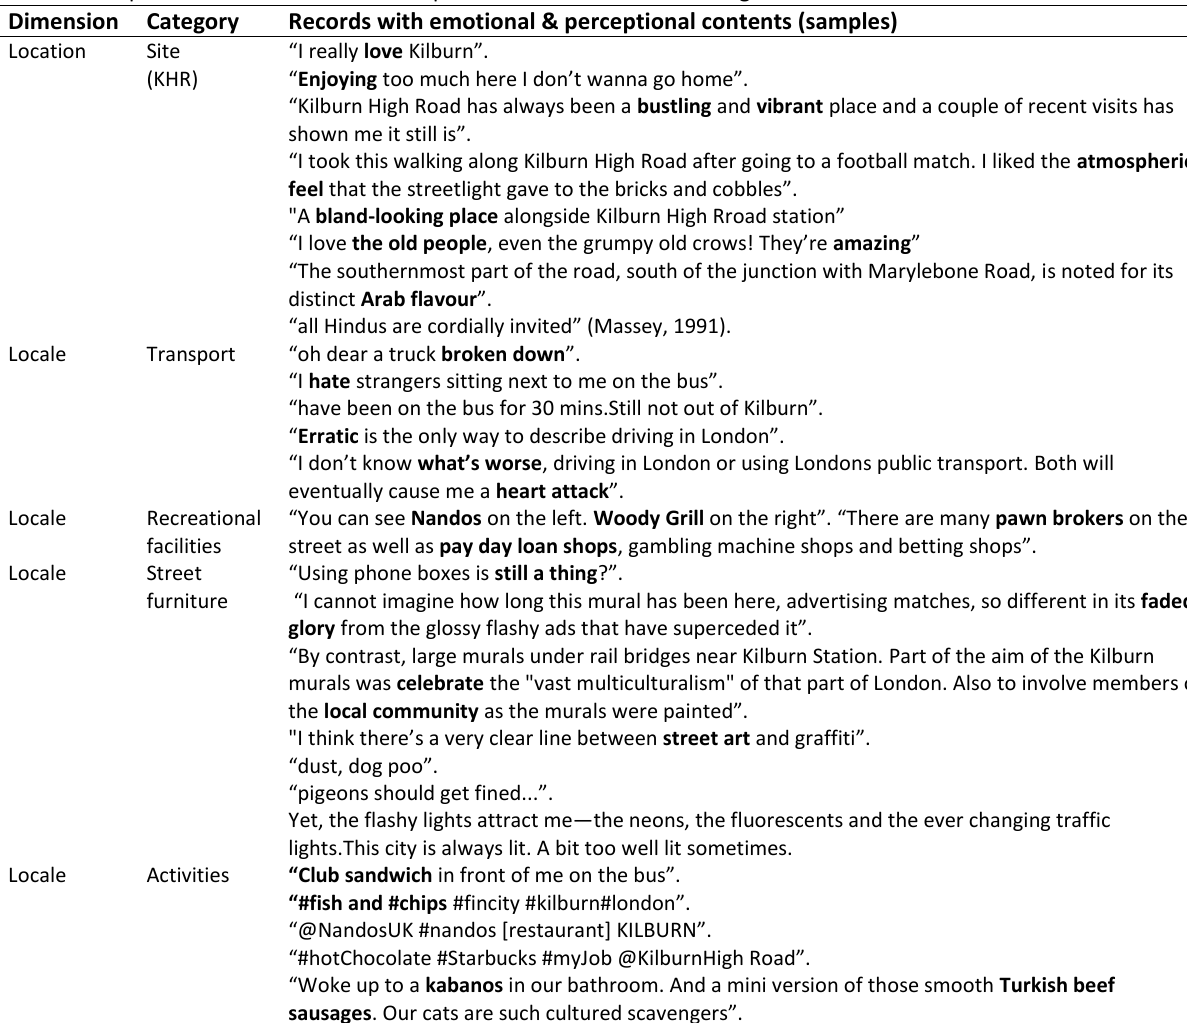
Table 7. Samples of records selected for exploration of emotions &